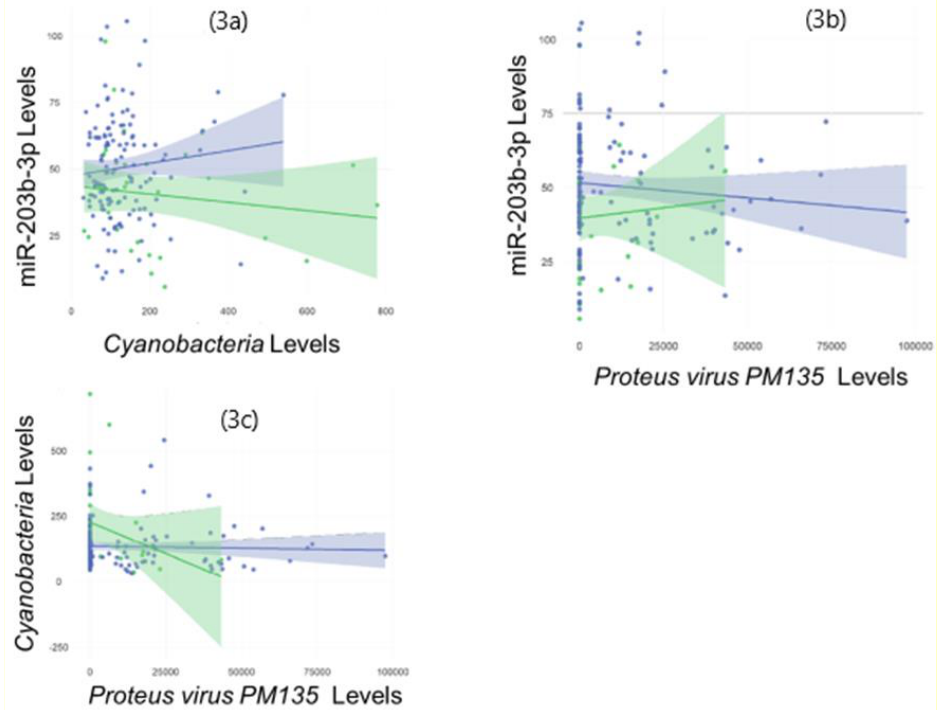
Figure 3. Multi-omic features implicated in food reactions display cross-category associations: The scatter plots display significant associations ( p < 0.05) between all three molecular features of interest on Spearman Rank Testing. The levels of miR-203b-3p were directly associated with Cyanobacteria levels (R = 0.53, p = 3.3 × 10 − 13 ) (3 a ), and inversely associated with Proteus virus PM135 (R = − 0.38, p = 5.2 × 10 − 7 ) (3 b ). The levels of Cyanobacteria and Proteobacteria virus PM135 were inversely associated (R = − 0.39, p = 2.8 × 10 − 7 ) (3 c ). Separate trend lines with 95% confidence intervals are displayed for participants with food reactions (green) and no food reactions (blue).